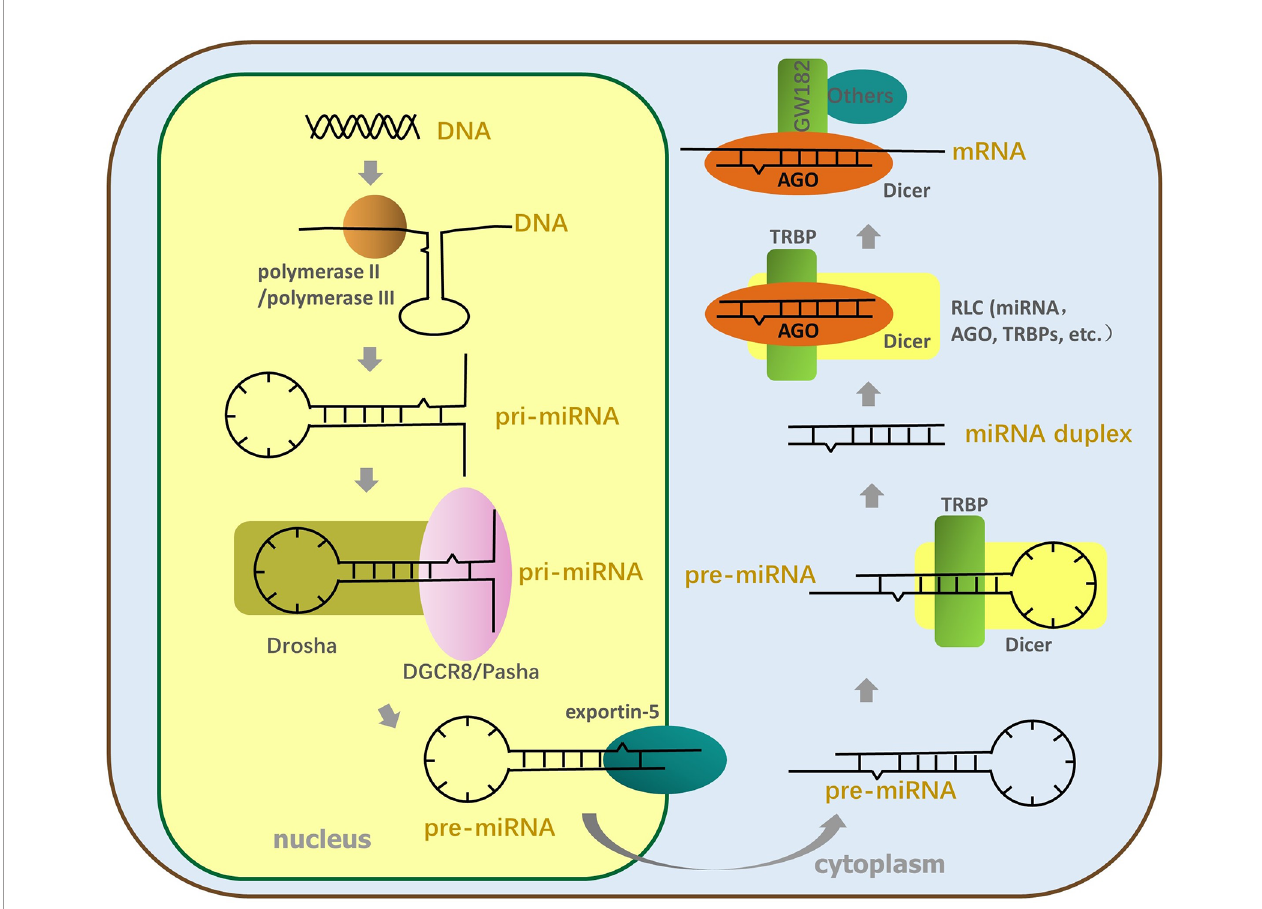
FIGURE 1 | The process of miRNA formation. The miRNA genes are transcribed for pri-miRNA by polymerase II or polymerase III; then, Drosha and DGCR8 split the pri-miRNA to form SL pre-miRNA, transferred to the cytoplasm by the export receptor, exportin-5. Next, the TL element of pre-miRNA is cut off by Dicer and TRBP to produce miRNA duplex. The miRNA duplex is transferred to RLC constituted by AGO, Dicer, TRBP, and so on and is then unfastened twice. The end, mature single-stranded miRNA enters RISC, and AGO of RISC recruits downstream factors to perform RNA